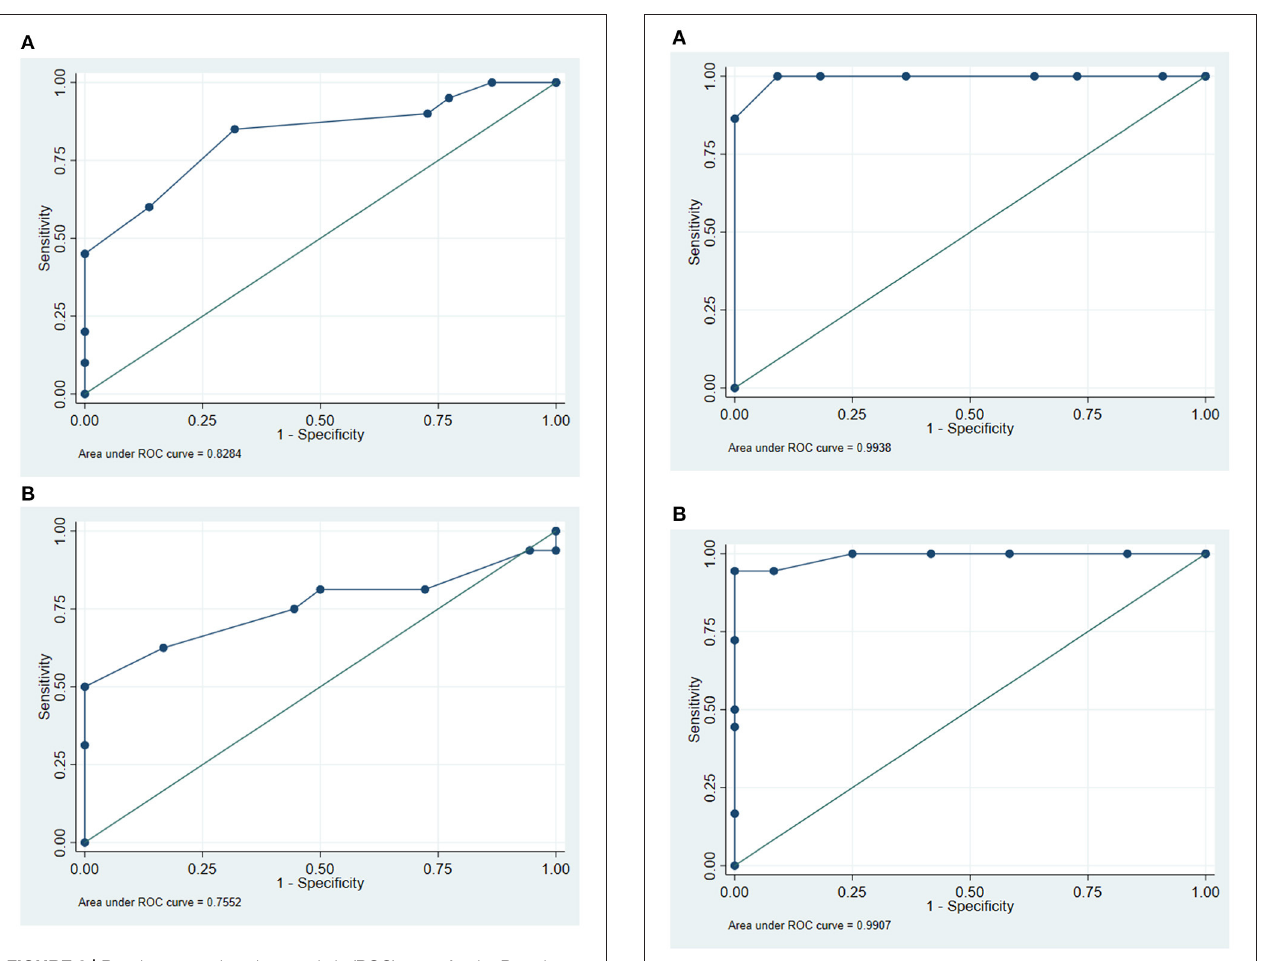
FIGURE 2 | Receiver-operating characteristic (ROC) curve for the Peruvian version of the Rowland Universal Dementia Assessment Scale (RUDAS-PE) for discrimination between mild cognitive impairment (MCI) and control groups. Chuquibambilla, Junín. (B) Receiver-operating characteristic (ROC) curve for the Peruvian version of the Rowland Universal Dementia Assessment Scale (RUDAS-PE) for discrimination between mild cognitive impairment (MCI) and control groups. Santa Clotilde, Loreto.